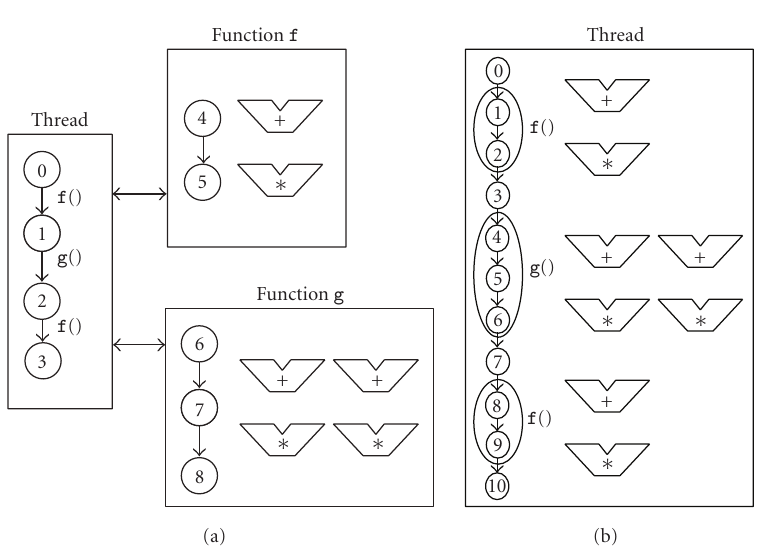
Figure 3: Function call methods in hardware. (a) Function exlining. (b) Function